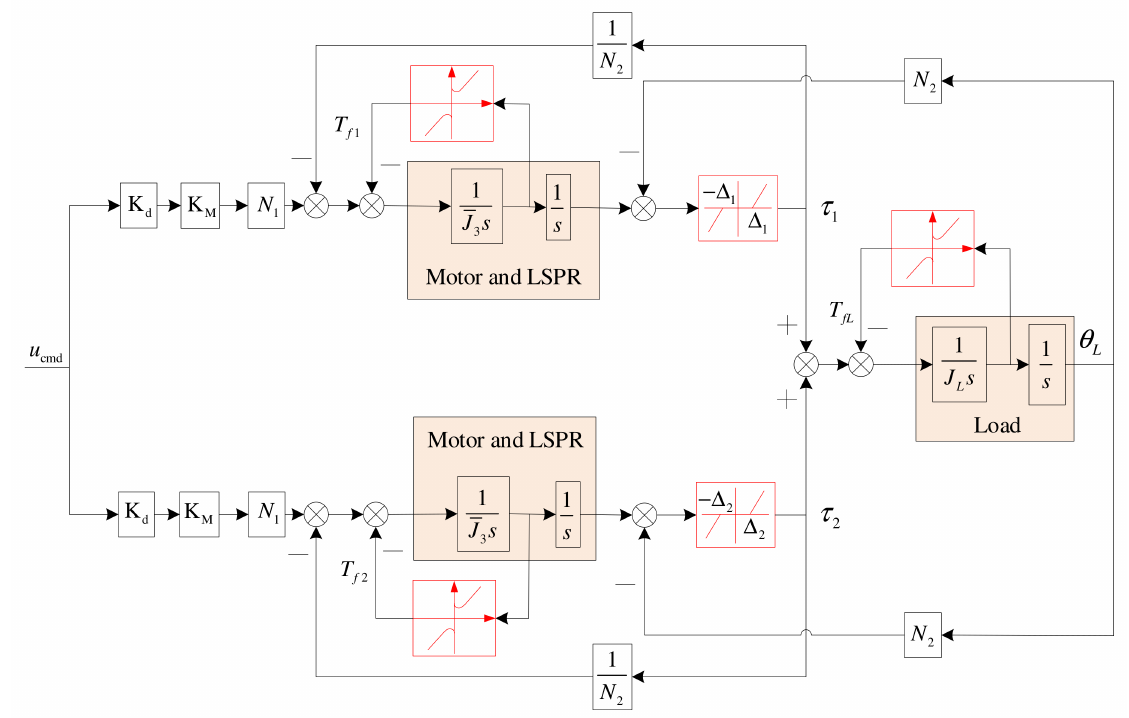
Figure 13. Block diagram of the nonlinear dynamic model of the DMPTM.